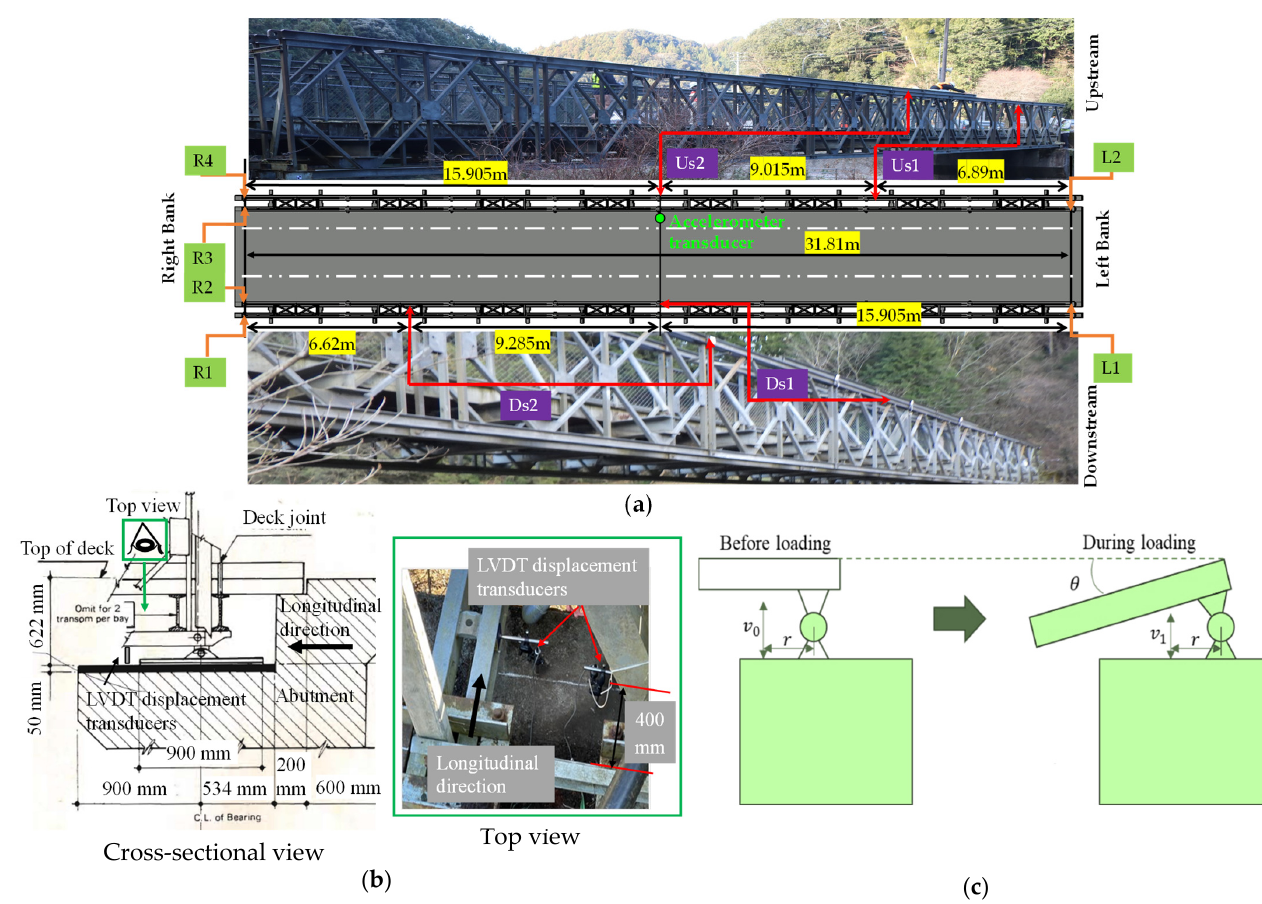
Figure 4. ( a ) Measurement instruments setup, ( b ) LVDT displacement transducer setup, ( c ) Determination of the deflection angle